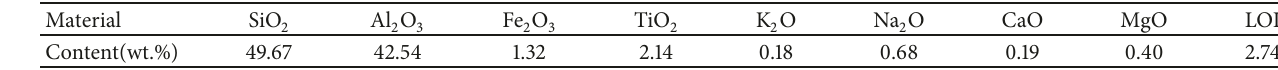
Table 1: Chemical composition of MK.